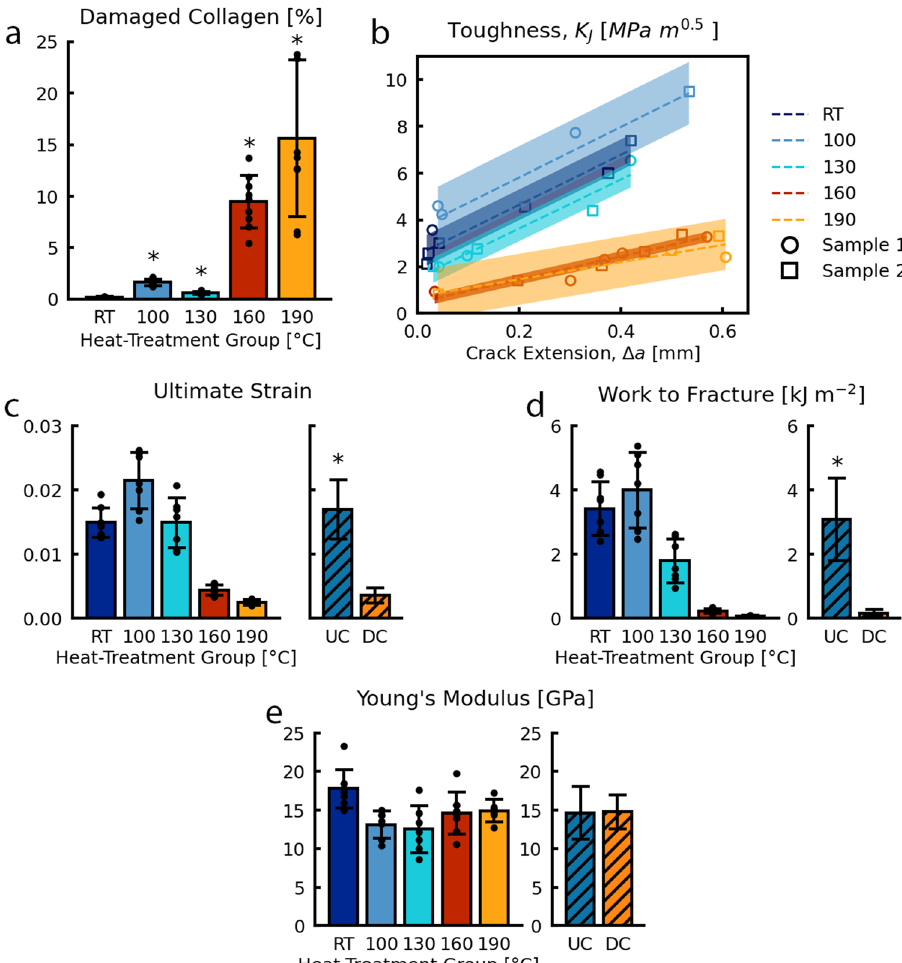
Fig. 2 Collagen damage is evident in results from biochemical, fracture toughness, and mechanical tests. Based on the trypsin-hydroxyproline assay, two general categories of collagen damage were de fi ned. The two groups were undamaged collagen (UC), including samples from RT, 100 °C, and 130 °C, and damaged collagen (DC), including the 160 °C and 190 °C samples. All bar-chart data are represented by mean ± standard deviation. a The trypsin- hydroxyproline assay ( N = 8 – 11/group), which measures the percent of damaged collagen, shows an increase in collagen damage with increases in heat- treatment temperature. Very little collagen damage was present in RT, 100 °C, and 130 °C groups. The 160 °C and 190 °C groups possessed much more damage than the lower-temperature groups. A Tukey multiple comparison tests showed that all groups were signi fi cantly different from one another. b The crack-resistance curves (R-curves) from the in situ SR μ CT toughness test ( N = 2/group) shows a marked decrease in toughness from the UC groups to the DC groups. c Flexural strength tests ( N = 6 – 8/group) were performed to obtain ultimate strain, work to fracture, and Young ’ s modulus. The ultimate strain was reduced from the UC groups to the DC groups. A Tukey test revealed that all temperatures were signi fi cantly different from each other except the RT and the 130 °C. d Work-to-fracture was greatly reduced from the UC groups to the DC groups. Tukey test showed that all groups were signi fi cantly different from each other except the RT and 100 °C, and the 130 °C and 160 °C. e Young ’ s modulus is largely unaffected by heat treatment; there was no signi fi cant difference between the UC and DC groups. A Tukey test revealed that the groups that were signi fi cantly different from each other include the RT and 100 °C, and the RT and 130